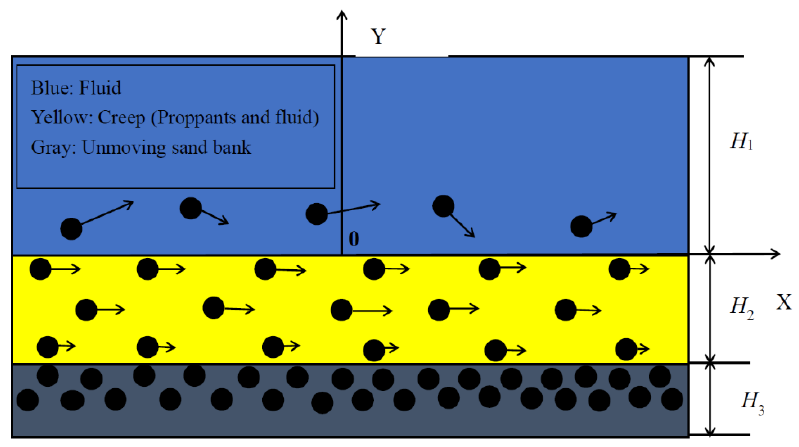
Figure 12. Illustration of proppant migration with saltation and creeping.